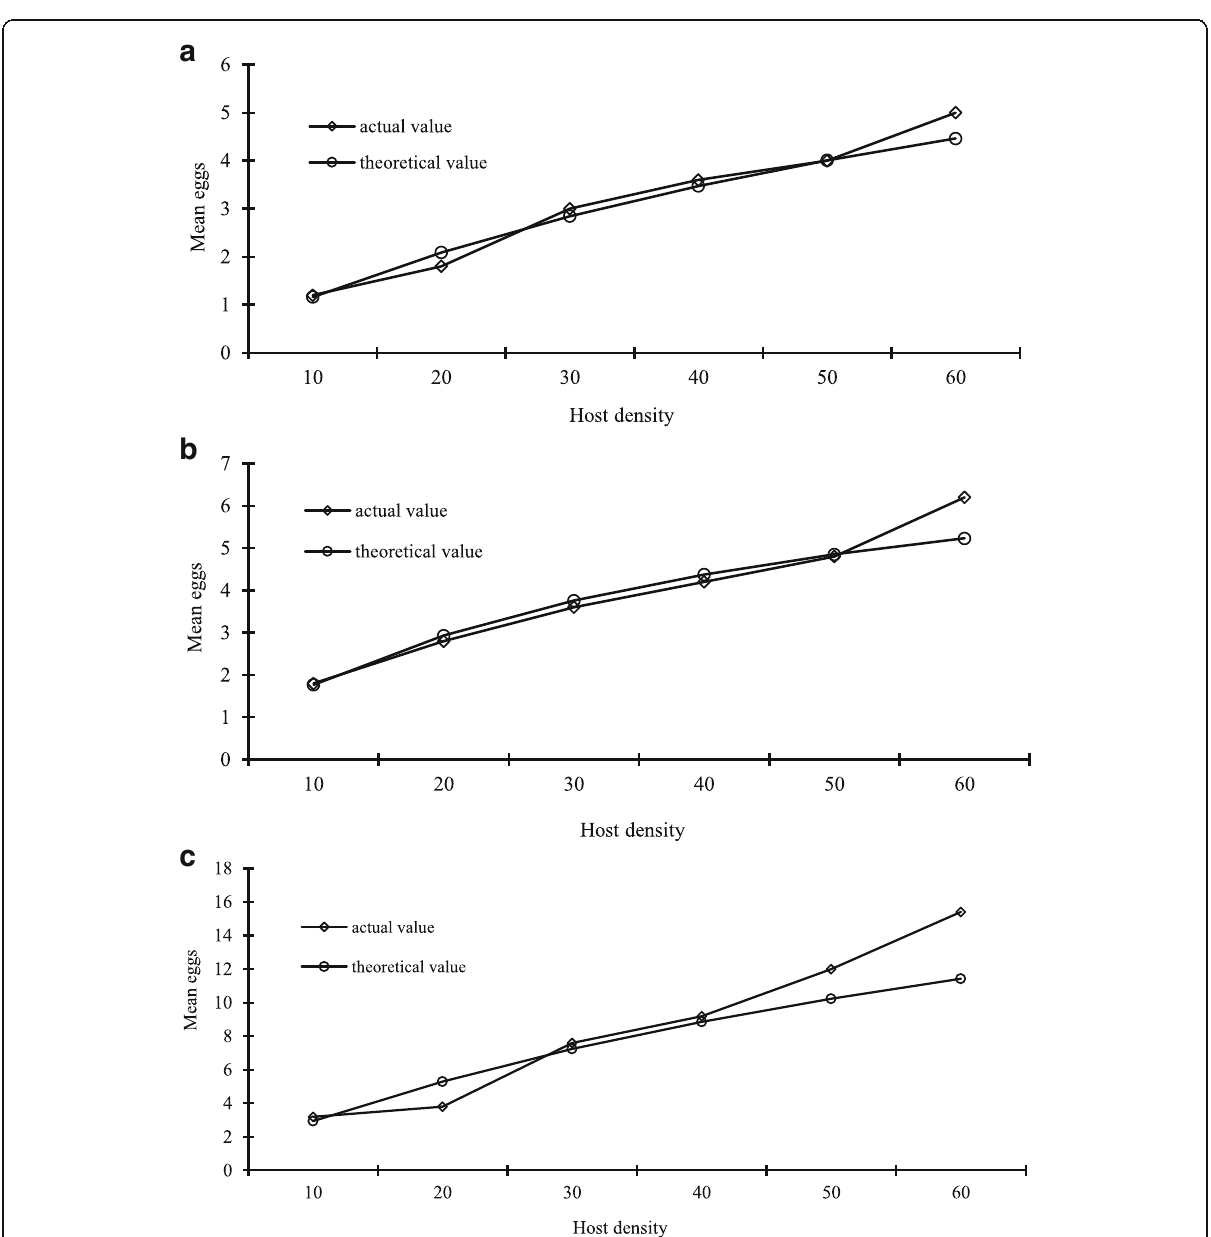
Fig. 1 Comparison of the actual and expected number of whitefly nymphs parasitized by three parasitoid species. a E. sophia. b E. bimaculata. c Er. sp. nr.